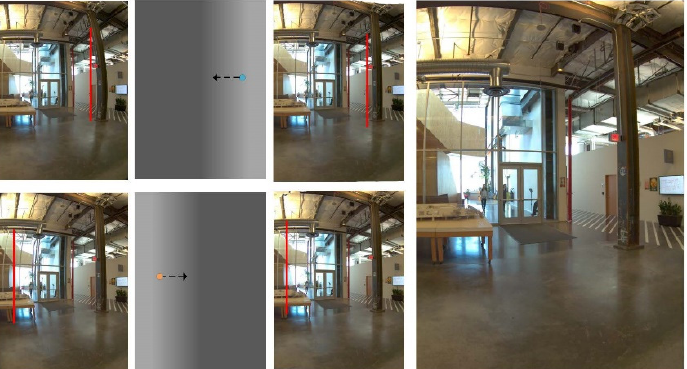
Figure 6. Optical flow adjustment and the synthesis of the novel viewpoint.